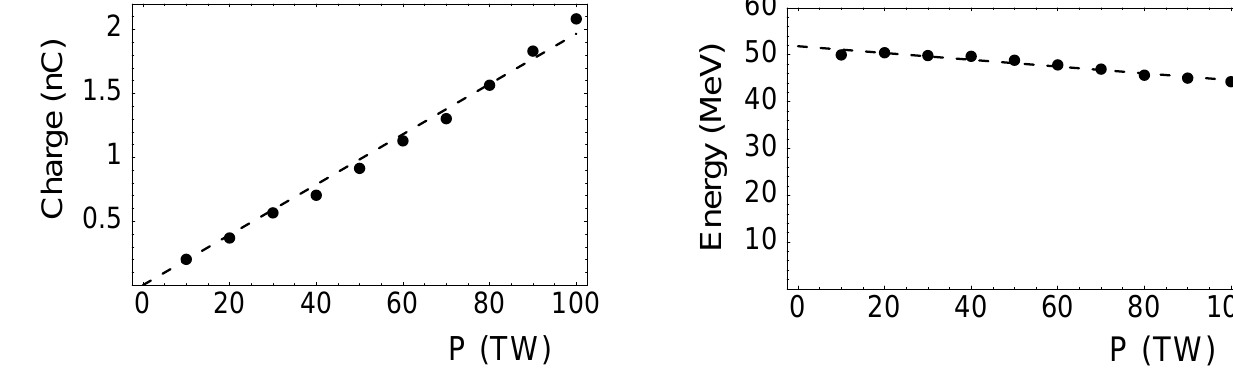
FIG. 12. Average energy after 2.7 mm acceleration for differ- ent bunches (see text), as a function of peak power. Dots are simulation results; the dashed line is a linear